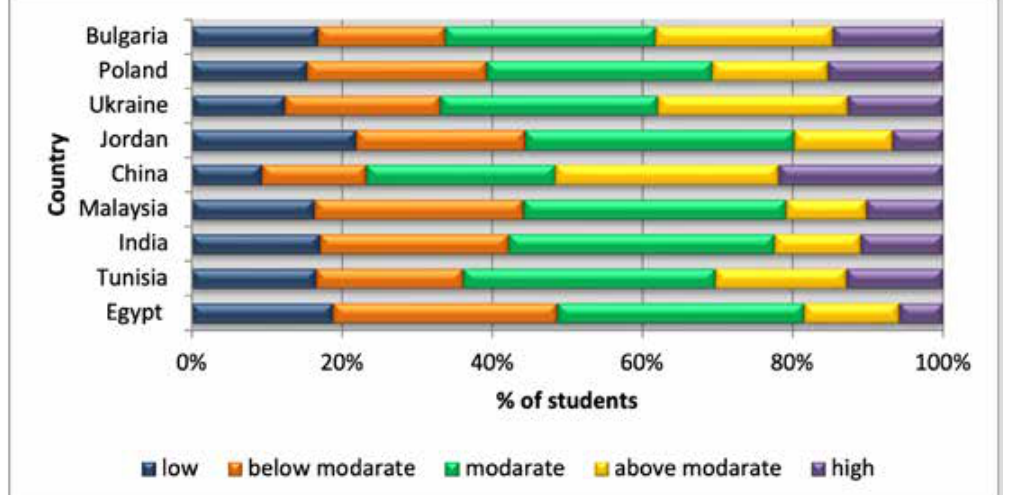
Figure 7. Distribution by levels of strength training of